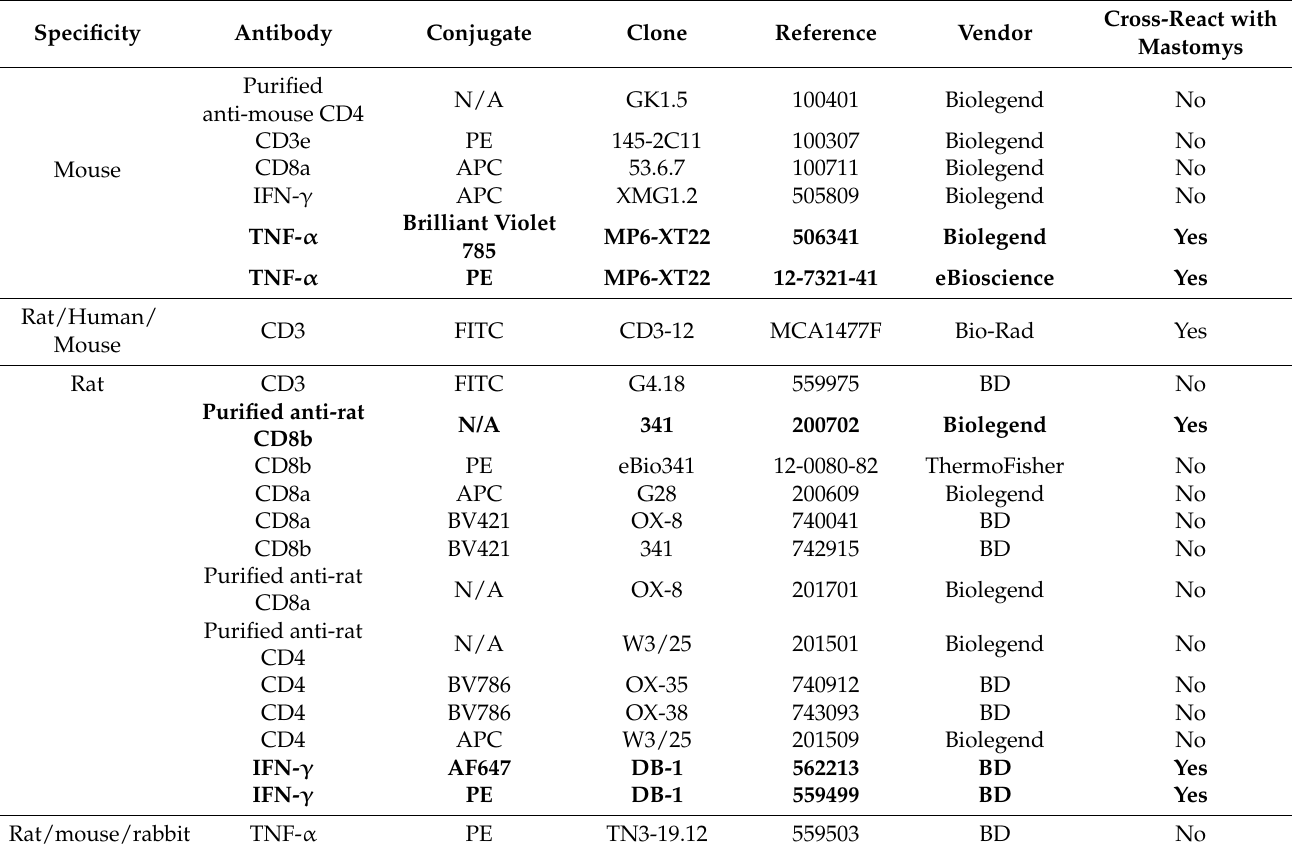
Table 3. Antibodies tested in this